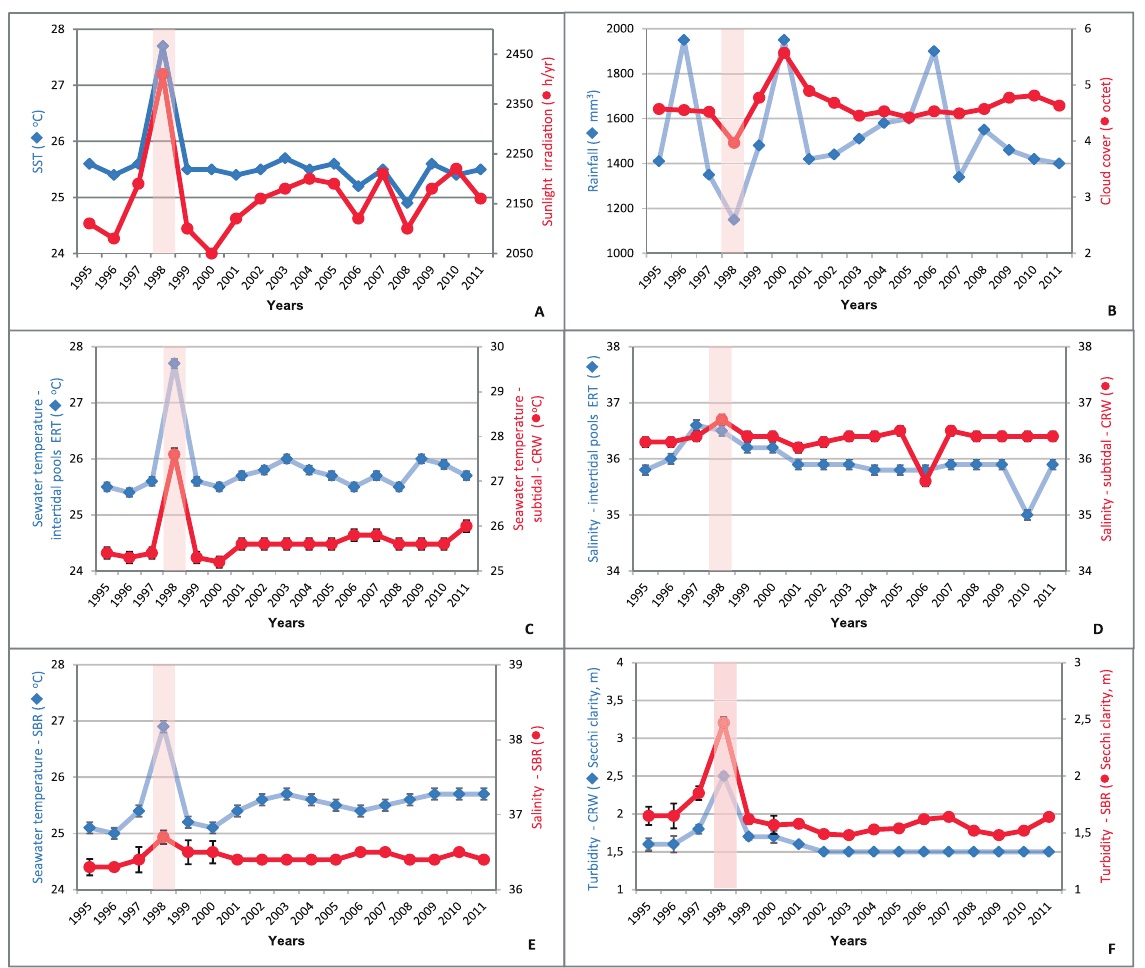
Figure 2. Summary of wide-scale (A–B) and locally measured (C–F) environmental variables recorded from the studied reefs throughout the sampling period, demonstrating changes in ambient conditions during the El Nin˜o period (1998). (A) Annual sea surface temperature and sunlight irradiance; (B) Annual rainfall and mean daily cloud cover; (C) Mean seawater temperature (ERT and CRW); (D) Mean salinity (ERT and CRW); (E) Mean seawater temperature and salinity (SBR); (F) Mean water clarity (CRW and SBR). Error bars indicate SE around the mean between replicate reef systems; Vertical bars represent the timing of the 1997–8 El Nin˜o event.